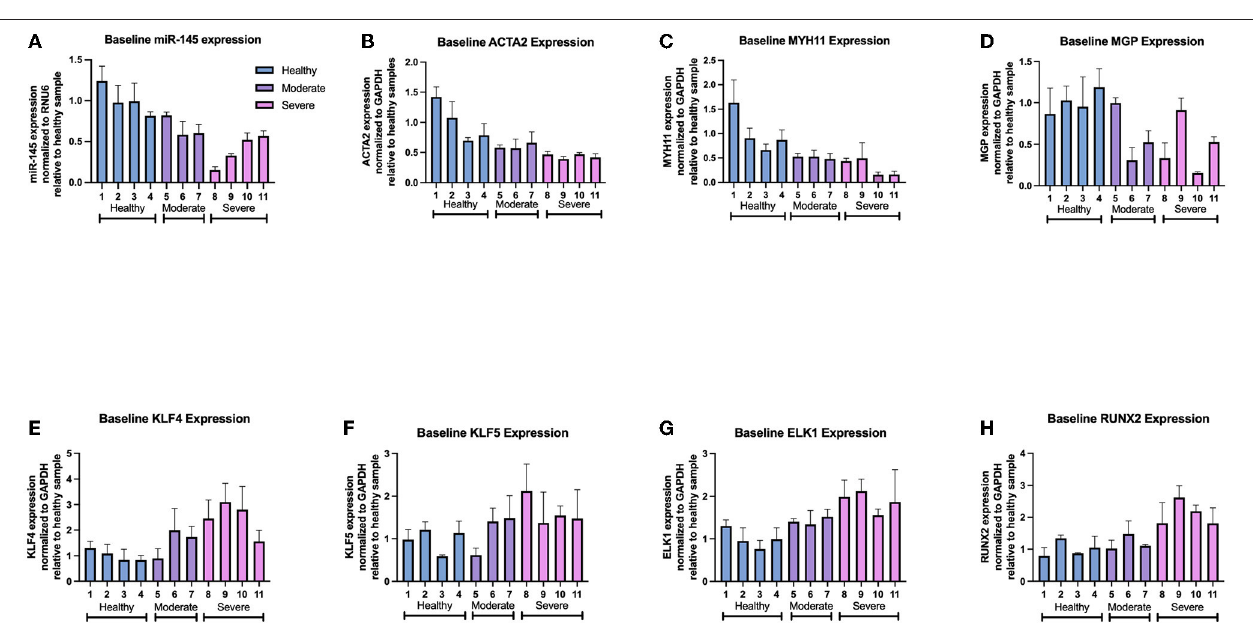
FIGURE 4 | Gene expression of individual patient-derived VSMCs for (A) miR-145, (B) ACTA2, (C) MYH11, (D) MGP, (E) KLF4, (F) KLF5, (G) ELK1, and (H) RUNX2 levels.